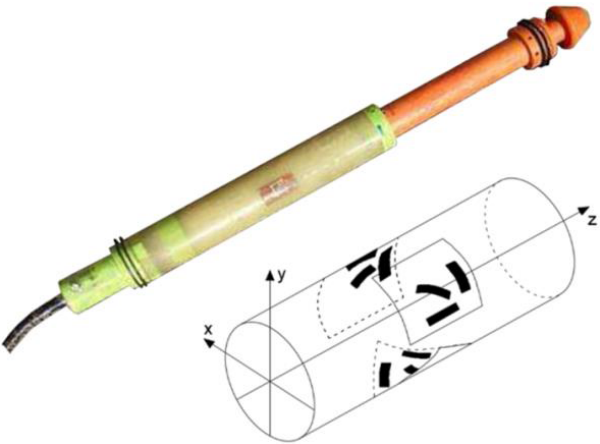
Figure 1. The hollow inclusion cell and a layout diagram of the strain gauges.